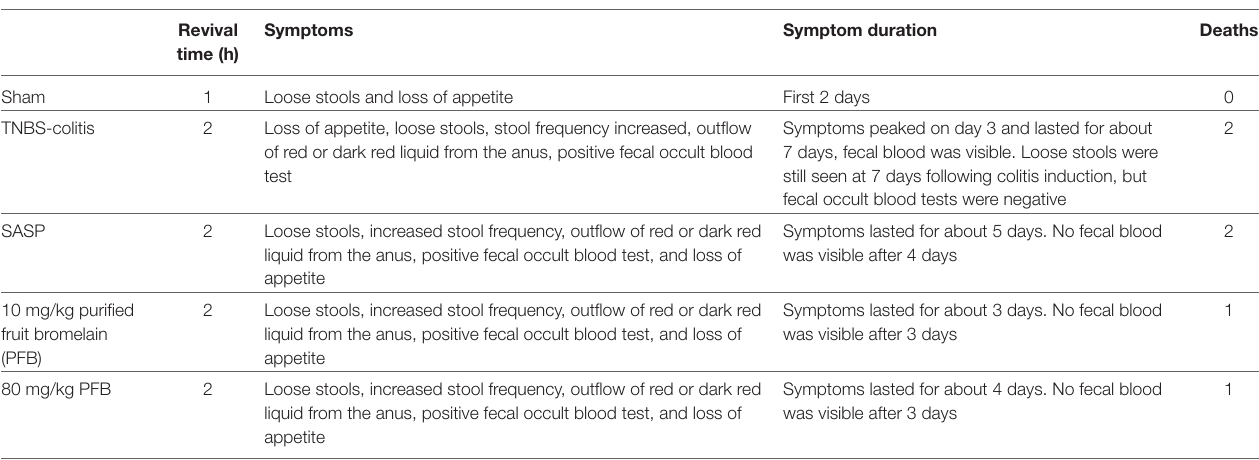
TaBle 1 | Colitis rat morphology and defecation.